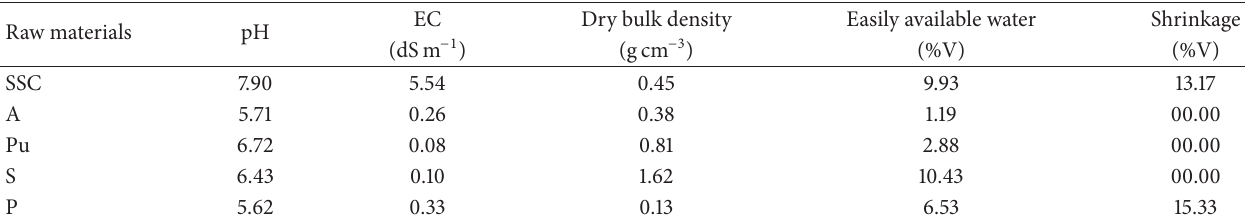
Table 3: Physical and physicochemical characteristics of the raw materials used: compost (SSC), almond shell (A), pumice (Pu), pozzolana (S), and sphagnum peat (P).